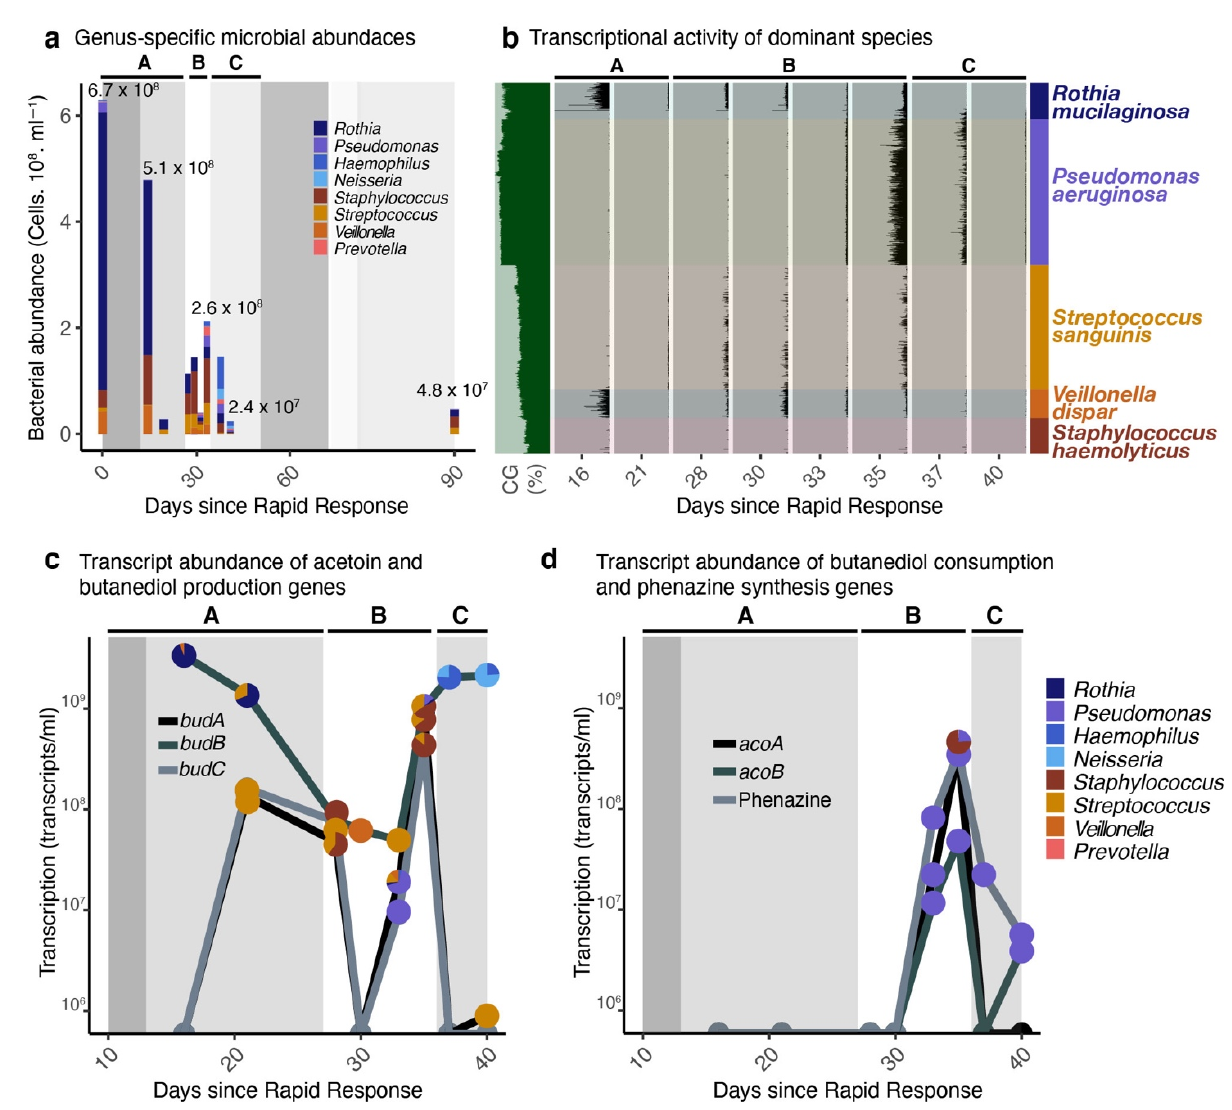
Figure 1. Bacterial abundances and transcriptional activity. ( a ) Changes in abundance of most abundant bacterial genera in the sputum from patient CF146. Abundances (in cell counts per mL of sputum) were obtained as the product of the fractional abundance from metagenomes normalized by genome size and by the total cell counts from epifluorescence microscopy. ( b ) Recruitment of metatranscriptomic reads to contigs obtained from sequencing the genomes of clinical bacterial isolates. The height of each peak in the plot denotes mean coverage of a contig divided by overall sample mean coverage and scaled to the microbial abundances per ml of sputum sample. As these are draft and not complete genomes, the position of each contig along the y axis is defined by k-mer similarity (k = 4) rather than position in the genome. The letters A, B and C within the plot area indicate the different antibiotic treatment periods. ( c ) Abundance of transcripts involved in the pathway of acetoin and butanediol production ( budA , budB , and budC ). Each point in the plot is divided by the taxonomic assignment of the transcripts. The transcript abundance per ml (y axis) was calculated as the product of the number of transcripts per Kb per taxon and the total number of Kbs of a that same taxon, calculated from the abundances and genome sizes. ( d ) Abundance of transcripts involved in the pathway of acetoin and butanediol consumption ( acoA and acoB ) and phenazine production ( phzABCDEFG , shown as a sum of all transcripts in this gene cluster). Each point in the plot is divided by the taxonomic assignment of the transcripts. The transcript abundance per mL (y axis) was calculated as in 4B.